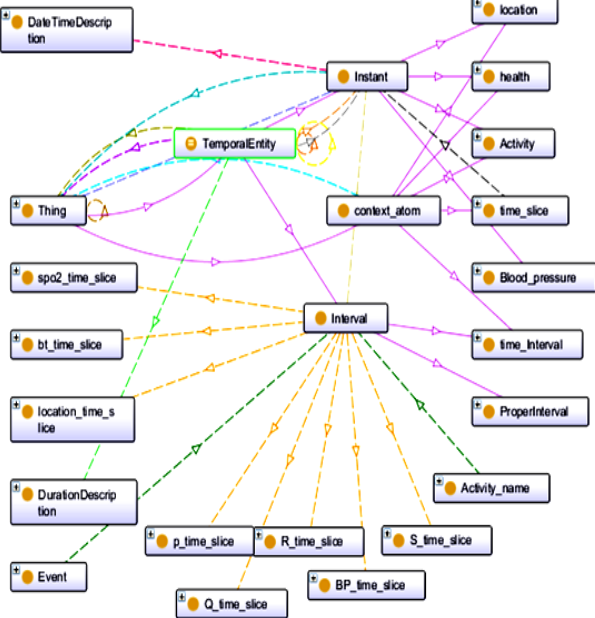
Figure 6.Relationship between classes, Time Slice and Time Interval.